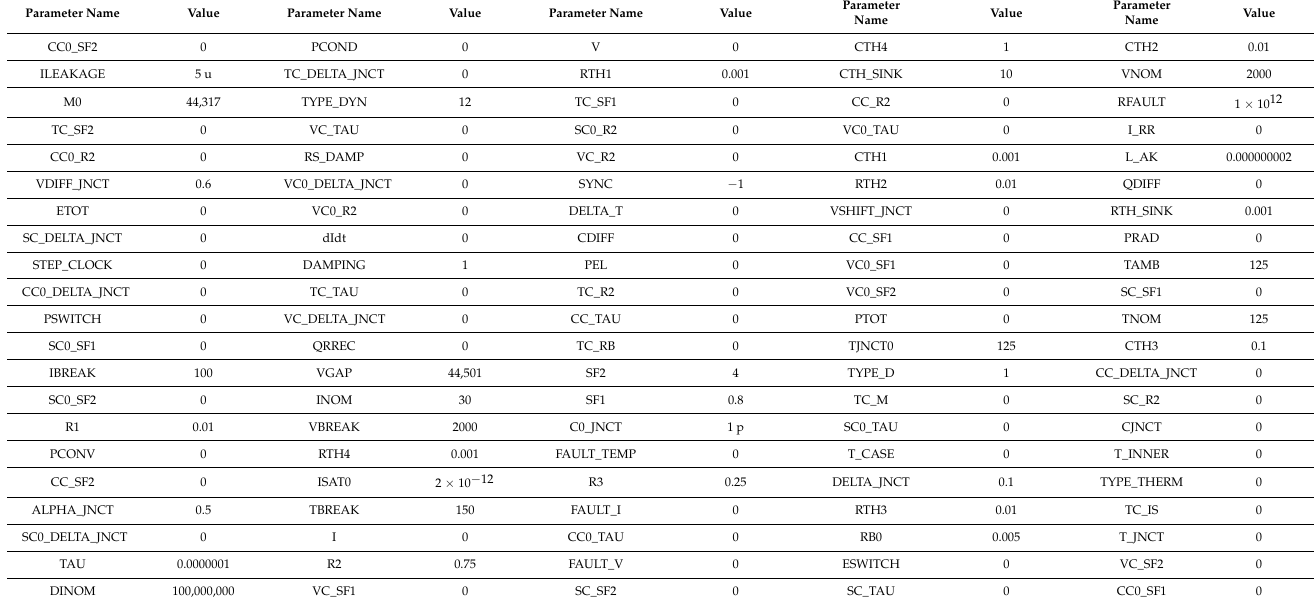
Table A3. Electrical parameters of the diodes—D5, D6 from Figure 6.